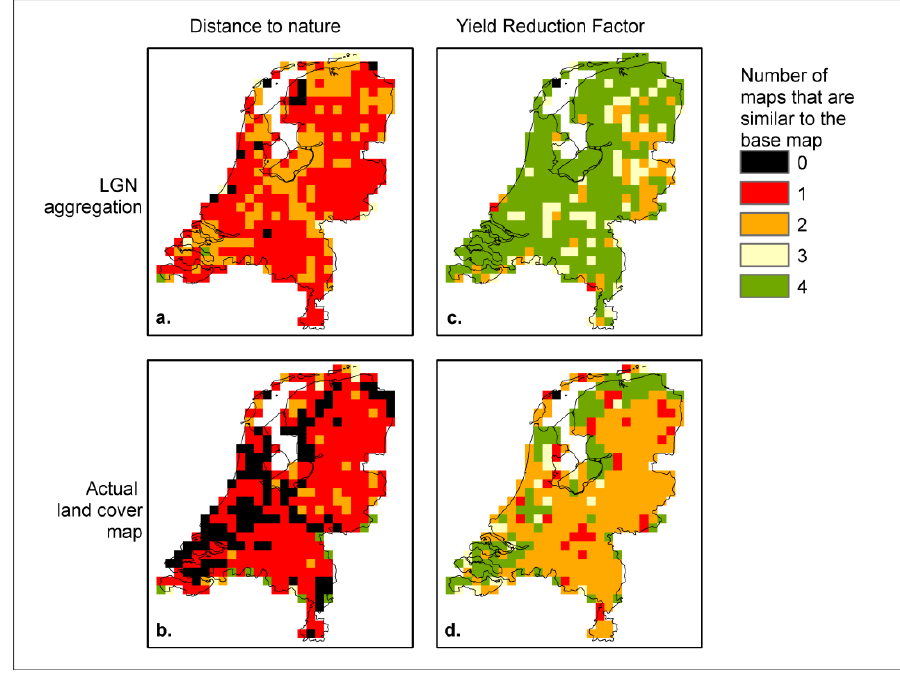
Figure 4. Number of maps that show a high similarity to the basemap. ( a ) D , real maps; ( c ) Yield reduction fraction, aggregated LGN aggregated LGN maps; ( b ) D nature maps; ( d ) Yield reduction fraction, real maps.